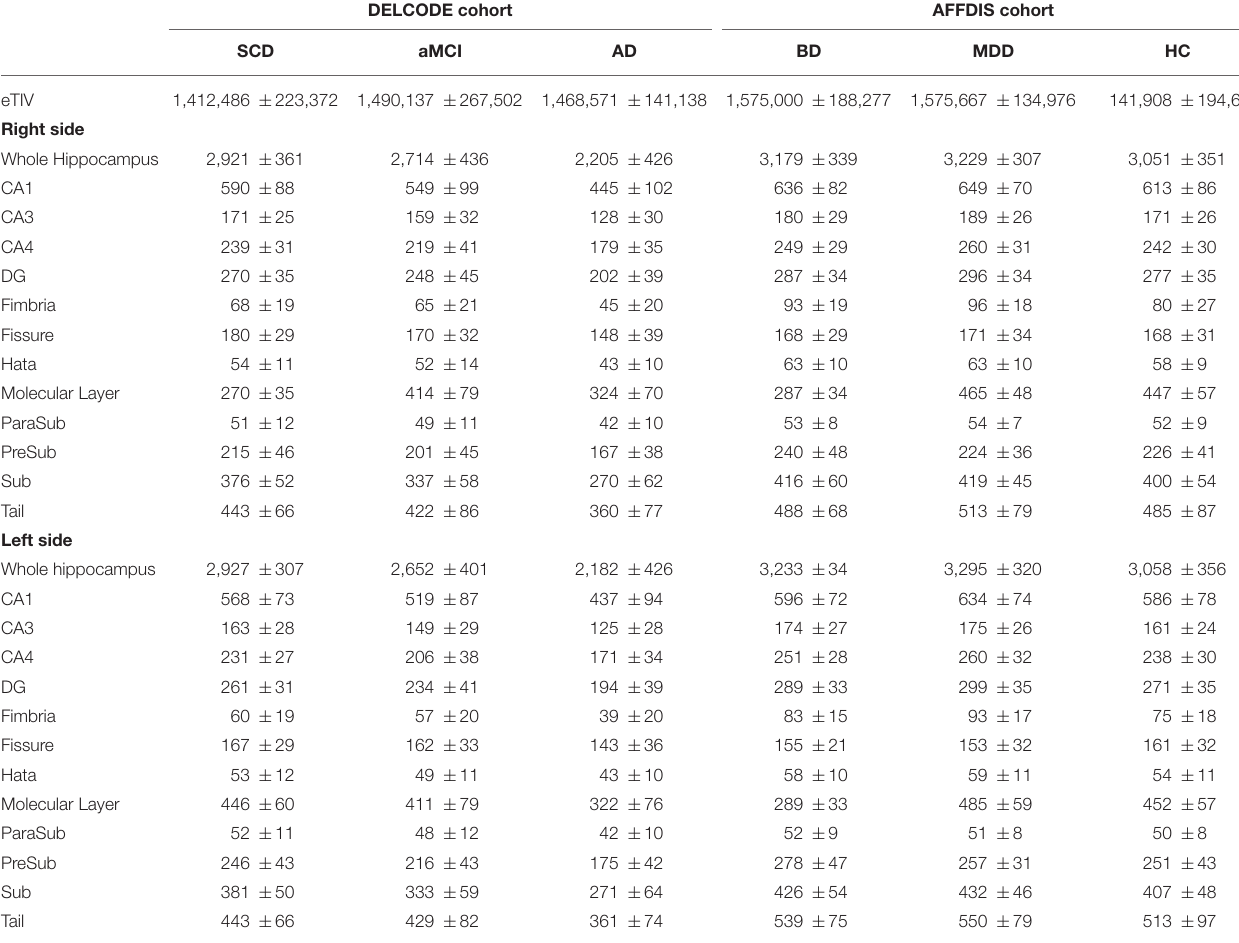
TABLE 2 | Neuroimaging data of patient and control